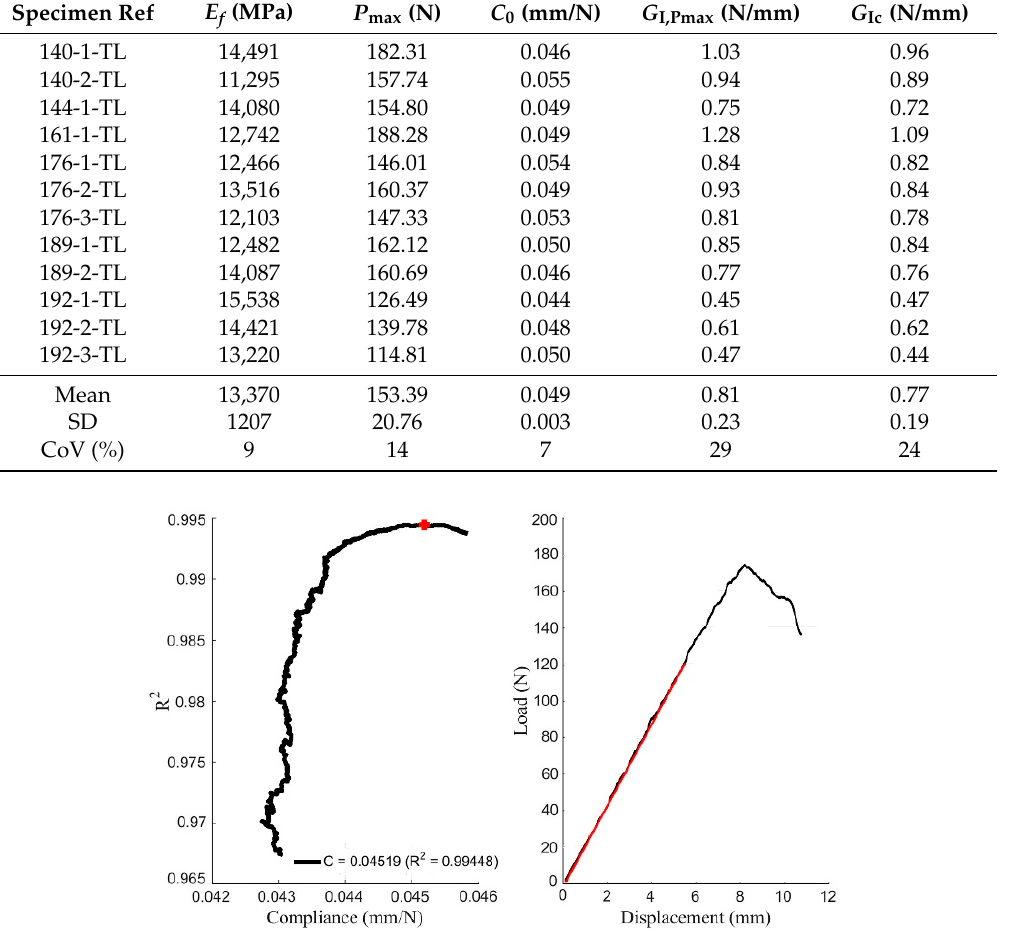
Table 4. Fracture energy obtained from DCB specimens oriented in TL by means of CBBM.